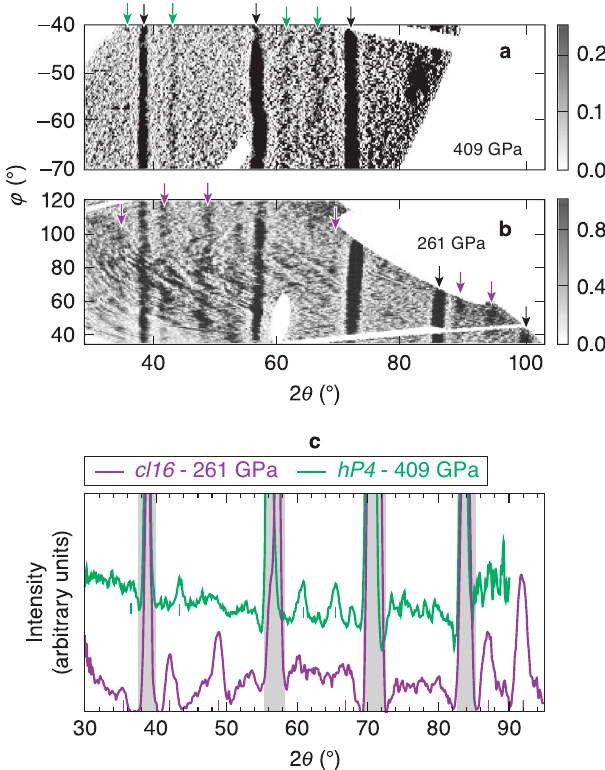
Fig. 3 X-ray diffraction data. a , b Diffraction data at 409±15GPa (shot 25877) and 261±11GPa (shot 27967), respectively. The Debye – Scherrer rings from compressed Na are marked with green and purple arrows. Black arrows mark W calibration diffraction peaks. c Lineouts along 2 θ for the image-plate data in ( a ) and ( b ) for cI16 (purple curve) and hP4 (green